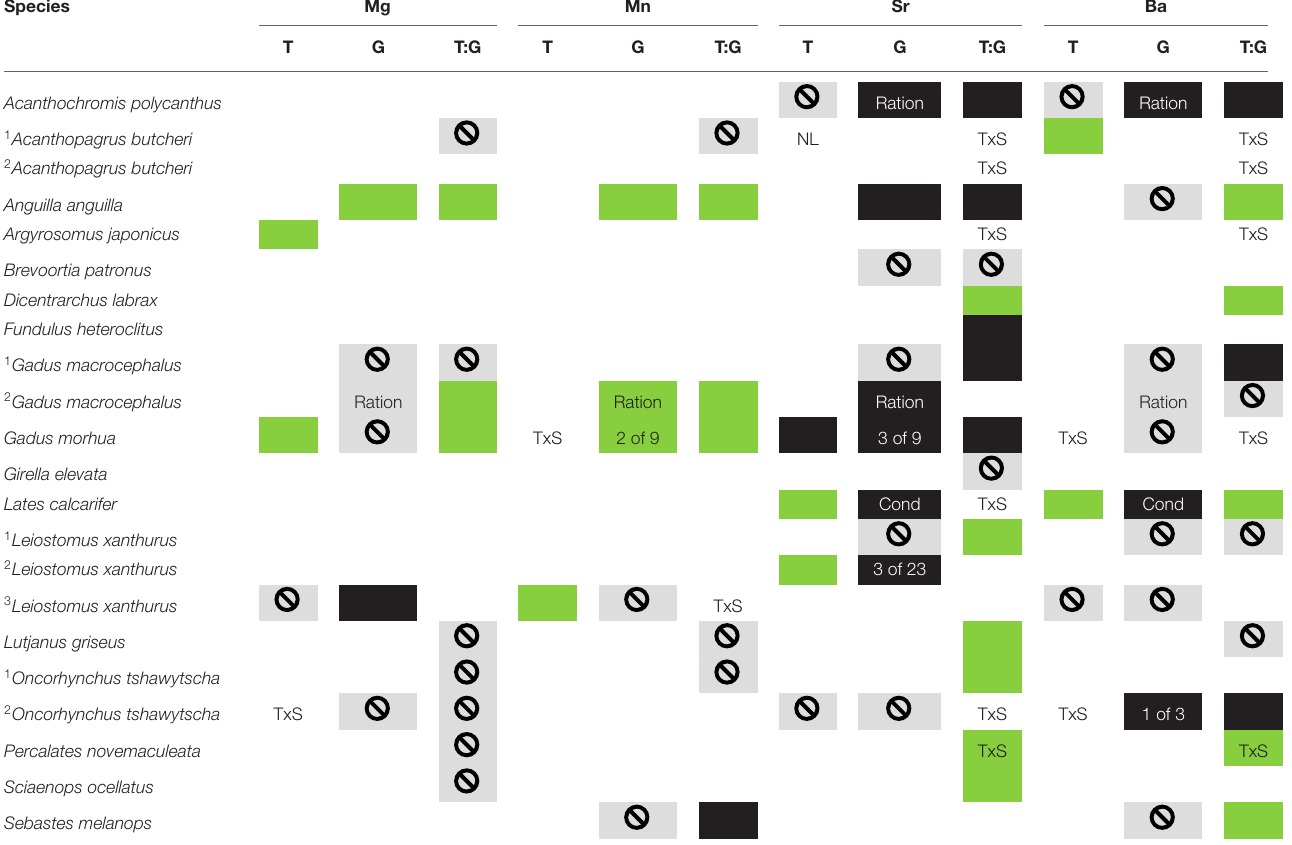
TABLE 2 | Review of studies that examined temperature and growth effects on otolith elemental incorporation of immature marine or euryhaline fish species.